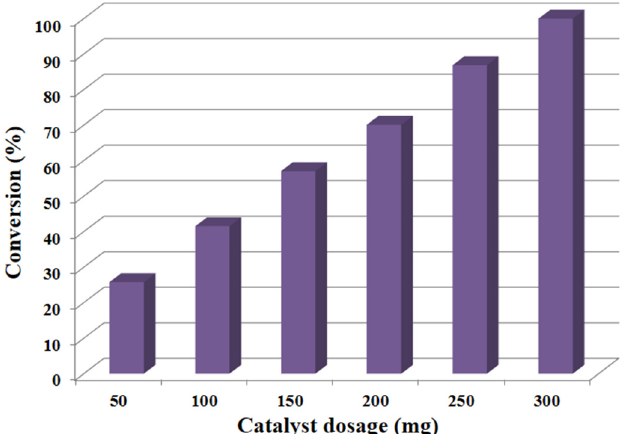
Figure 8. Conversion of BzOH as a function of catalyst (1%)Co x O y –MnCO 3 dosage.